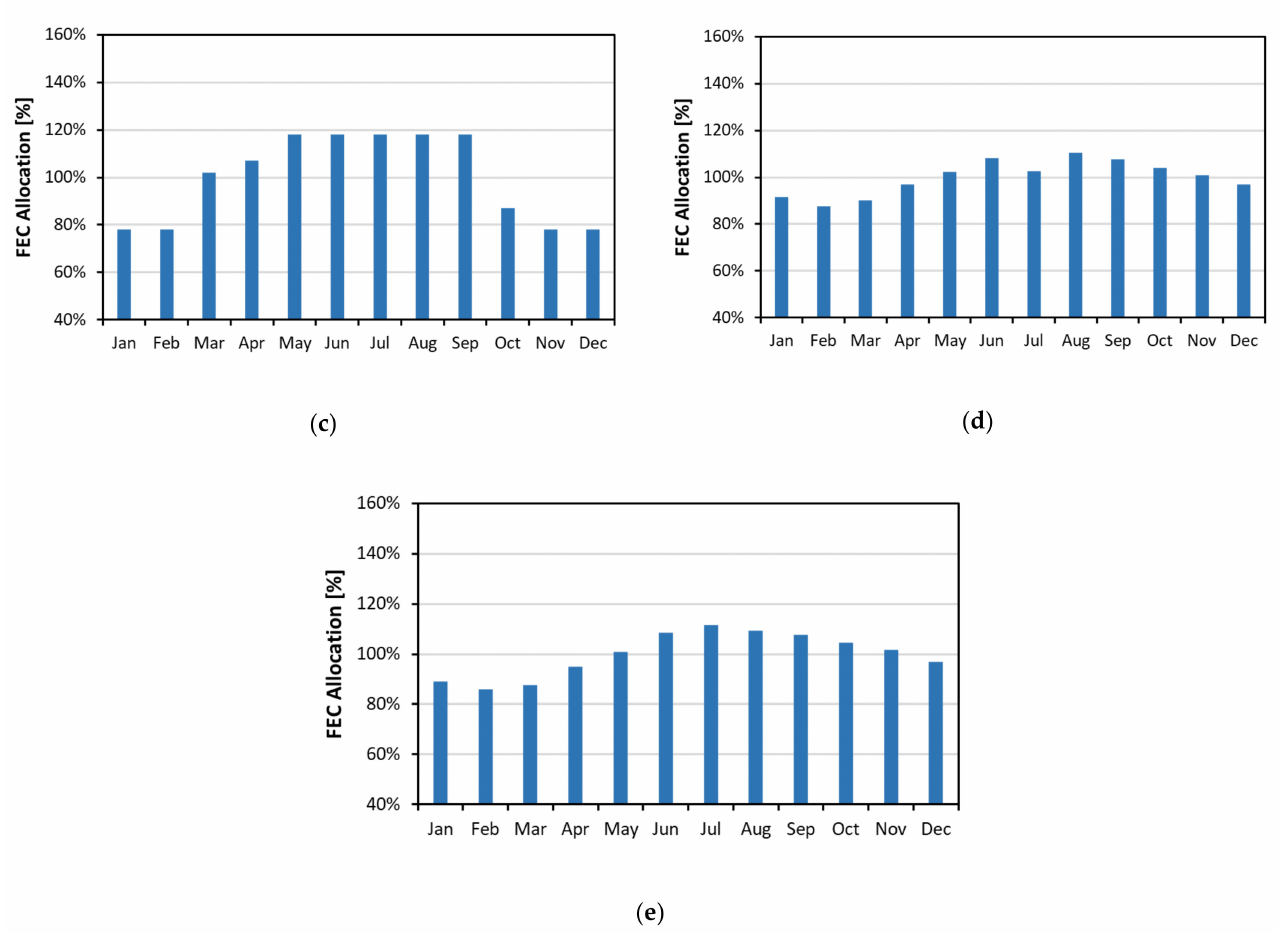
Figure 9. Player 1’s strategies: ( a ) 2014; ( b ) 2015; ( c ) 2016; ( d ) 2017; and ( e ) 2018. Figure 10 graphs Player 2 (cid:48) s (hydro generator with FEC equal to 1 MWavg) strategies for 2019 emulated by the stochastic optimization model and considering each criterion pro- vided in Table 1. As a premise, the values of 160% and 40% for L max and L min , respectively, were applied. Furthermore, as explained in Section 5.1.2, to simplify the presentation of results, strategies with similar patterns were clustered in one profile, resulting in Player 2 (cid:48) s six strategies.